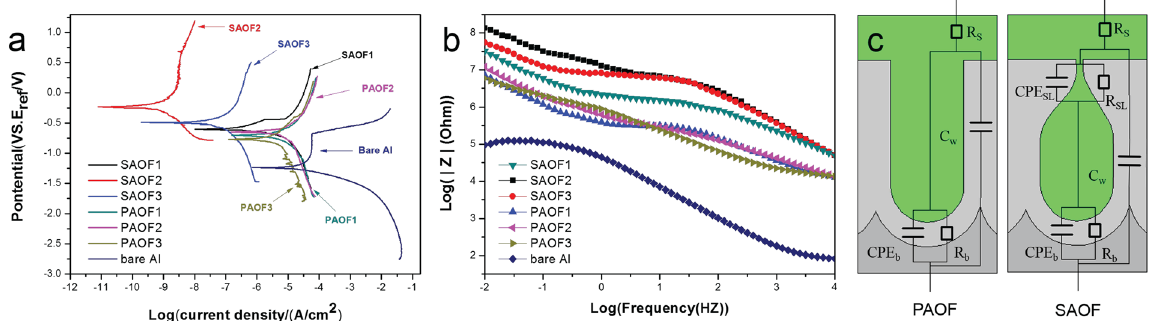
Figure 2. Potentiodynamic polarization, bode plot and equivalent circuits of self-sealing AOFs, PAOFs and Al